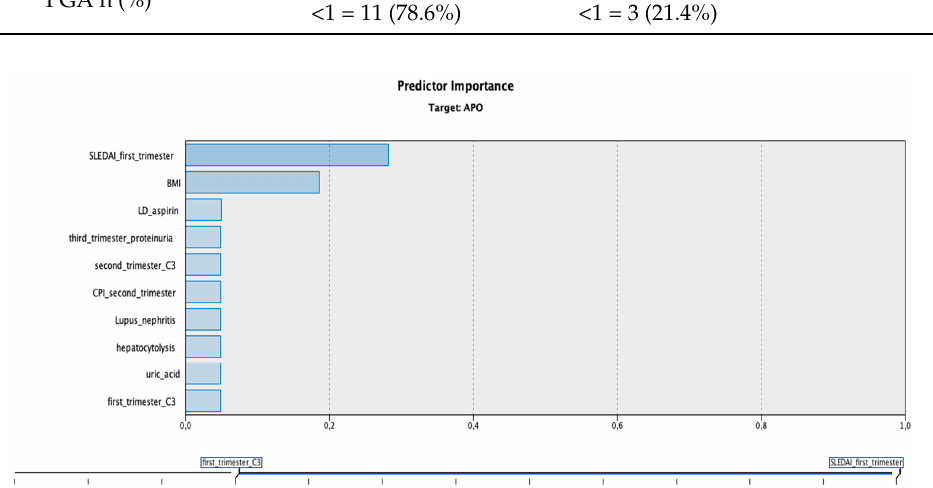
Figure 1. Importance of the predictors targeting adverse pregnancy outcomes according to the dis- criminant model. Legend: APO, adverse pregnancy outcome; SLEDAI_first_trimester, SLEDAI-2k score ≥ 4 from the first trimester; BMI, body mass index; LD_aspirin, use of low-dose aspirin; third_trimester_proteinuria, proteinuria present in the third trimester; second_trimester_C3, low complement (C3) in the second trimester; CPI_second_trimester, cerebroplacental index in the sec- ond trimester; Lupus_nephritis, personal history of lupus nephritis; hepatocytolysis, hepatic cytol-